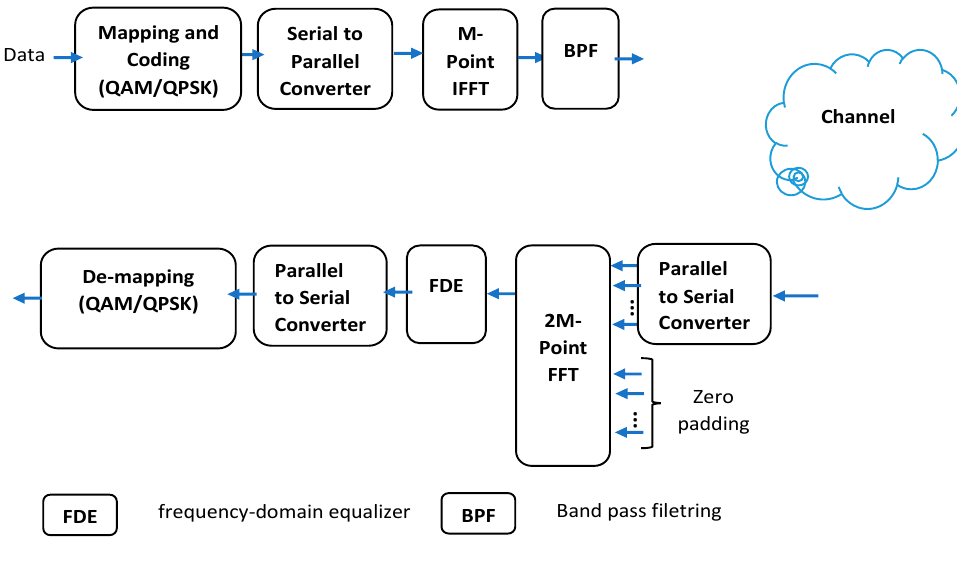
Figure 9. UF-OFDM transceiver.